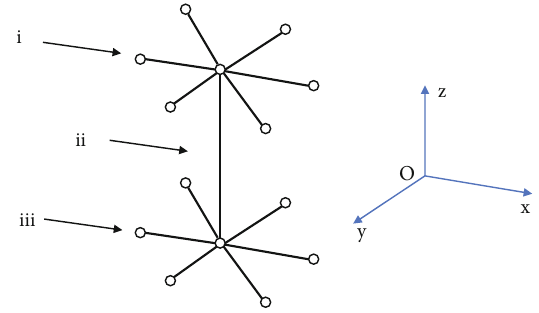
Figure 5: A cable net unit. (a) Front cable net. (b) Tension tie cable. (c) Back cable